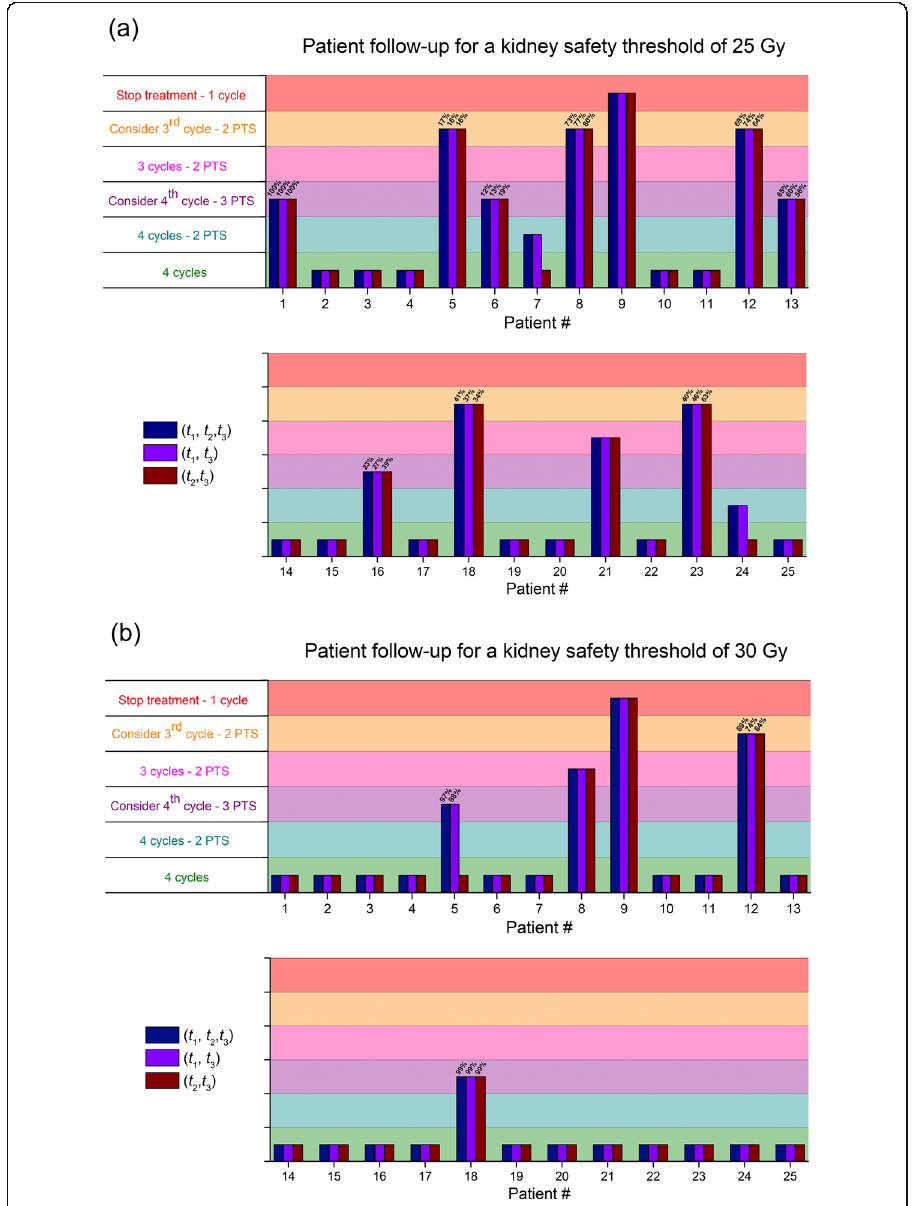
Fig. 3 Management of the 25 patients included in the study based on the kidney cumulative dose “ predicted ” after one, two, or three post-treatment scan(s) (PTS) and calculated either by using the standard protocol or by using the ( t 1 , t 3 ) or ( t 2 , t 3 ) “ 2 time-points ” protocols with a safety threshold fixed at a 25 Gy and b 30 Gy. Each color bar represents different protocol. Horizontal lines delimit the different managements of the patient (4 CYCLES: the patient can receive 4 cycles of treatment safely, 1 PTS only; 4 CYCLE — 2 PTS: the patient can receive 4 cycles of treatment safely, 2 PTS only; CONSIDER A fourth CYCLE — 3 PTS: consider to administer a fourth cycle of treatment based on the probability to exceed the safety threshold after 4 cycles; 3 CYCLES — 2 PTS: the patient can receive only 3 cycles of treatment safely, 2 PTS only; CONSIDER A third CYCLE — 2 PTS: consider to administer at maximum a third cycle of treatment based on the probability to exceed the safety threshold after 3 cycles; STOP TREATMENT — 1 cycle: stop treatment after a single cycle of